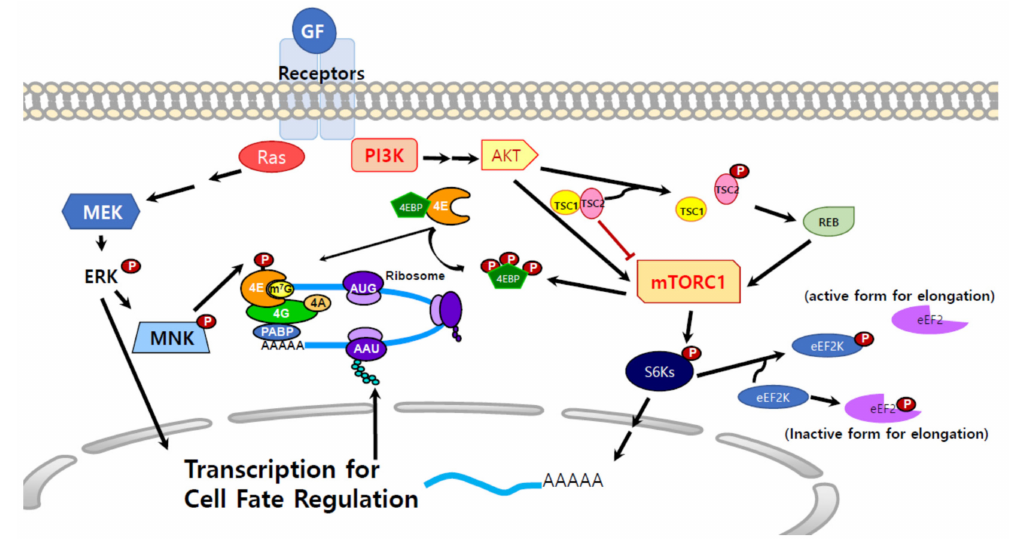
Figure 2. Signaling pathways that influence protein synthesis. Signals that are activated by growth factors not only a ff ect transcription but also translation. Mitogen-Activated Protein Kinase Interacting Protein Kinases (MNKs) can be phosphorylated by activated extracellular signal-regulated kinases (ERKs) and further phosphorylate eIF4E, which is important for recruiting mRNA for translation initiation. Binding of the growth factors to the receptors activates phosphatidylinositol 3-kinase (PI3K) and AKT. Activated AKT phosphorylates tuberous sclerosis complex 2 (TSC2), which leads to the dissociation of the TSC1 / TSC2 complex that negatively regulates mammalian target of rapamycin complex 1 (mTORC1) and leads to mTORC1 activation. mTORC1 hyper-phosphorylates 4EBP, which results in the release of eIF4E for protein synthesis. Activated mTORC1 also activates S6Ks, which further activate eukaryotic translation elongation factor 2 (eEF2) and facilitate